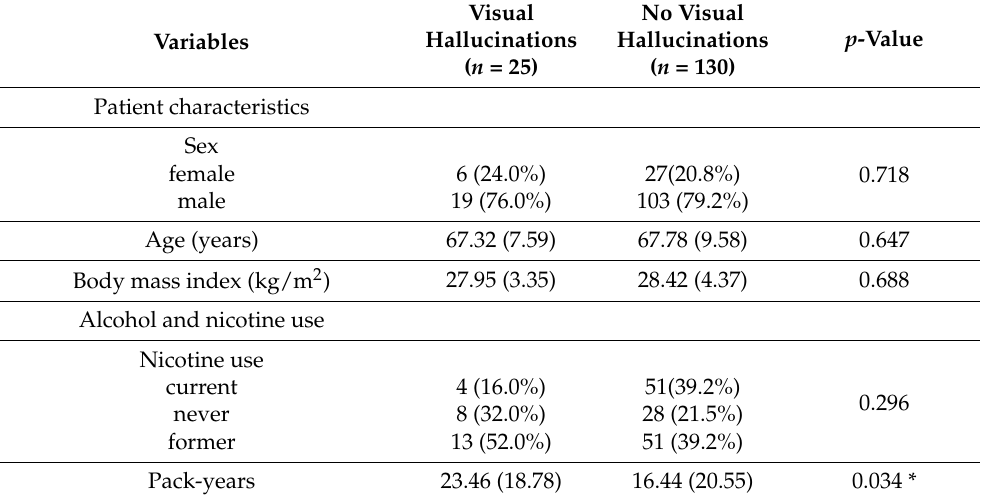
Table 2. Comparison of preoperative, intraoperative, and postoperative data of the patients with visual hallucinations vs. without visual